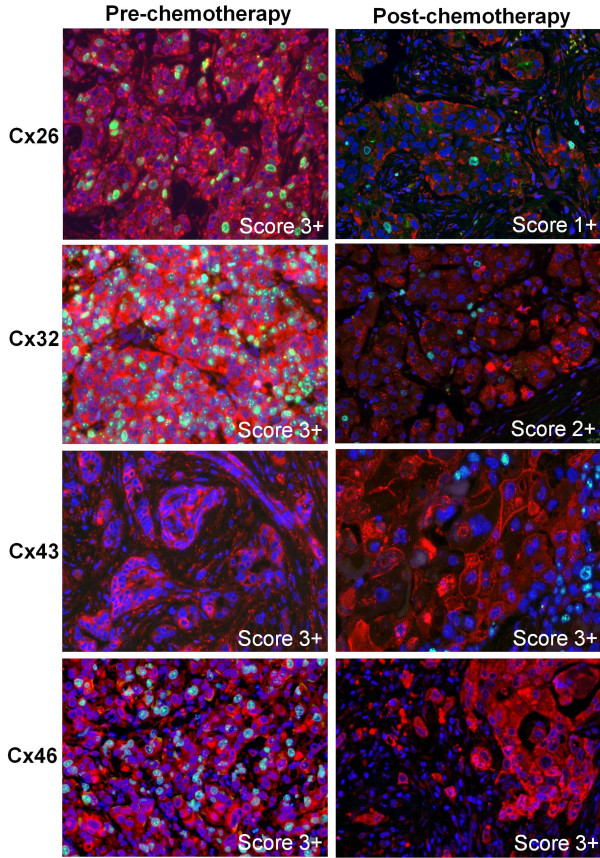
Immunofluorescence detection of Cx26, Cx32, Cx43, Cx46 (Alexa 546, red) and Ki67 (Alexa 488, green) in invasive ductal breast cancers prior to (pre-) and after (post-) neoadjuvant chemotherapy. Cell nuclei were stained using Hoescht (blue). Punctuate cell membrane associated and cytoplasmic Cx26 (1st row) and Cx32 (2nd row) levels and the proliferating (green) tumour cell fractions were reduced after neoadjuvant therapy in cases originally scoring 3+. Cx43 (3rd row) and Cx46 (4th row) levels did not change after neoadjuvant chemotherapy in cases of high scores (3+). Pre-chemotherapy Cx43 and post-chemotherapy Cx46 samples are not stained for Ki67.